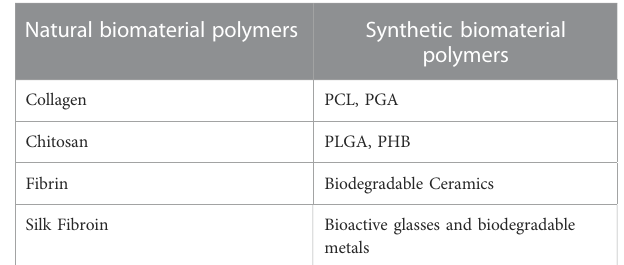
TABLE 2 Classi fi cation of biological materials.